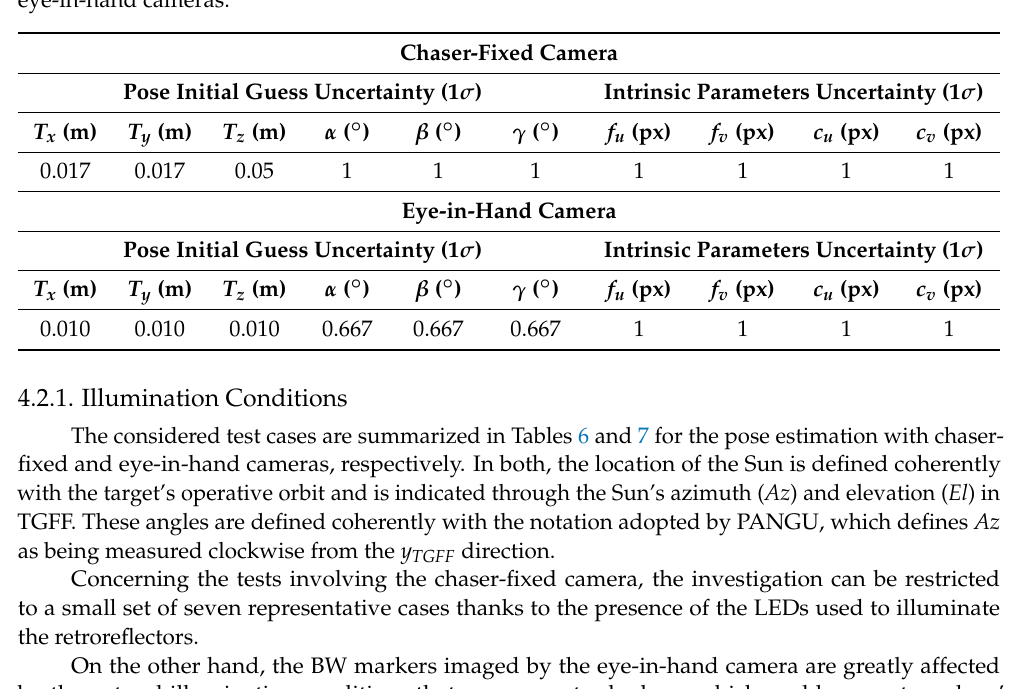
Table 5. Error level (1 σ ) in the knowledge of pose initial guesses and camera intrinsic pa- rameters considered in the simulations for both the pose determination with chaser-fixed and eye-in-hand